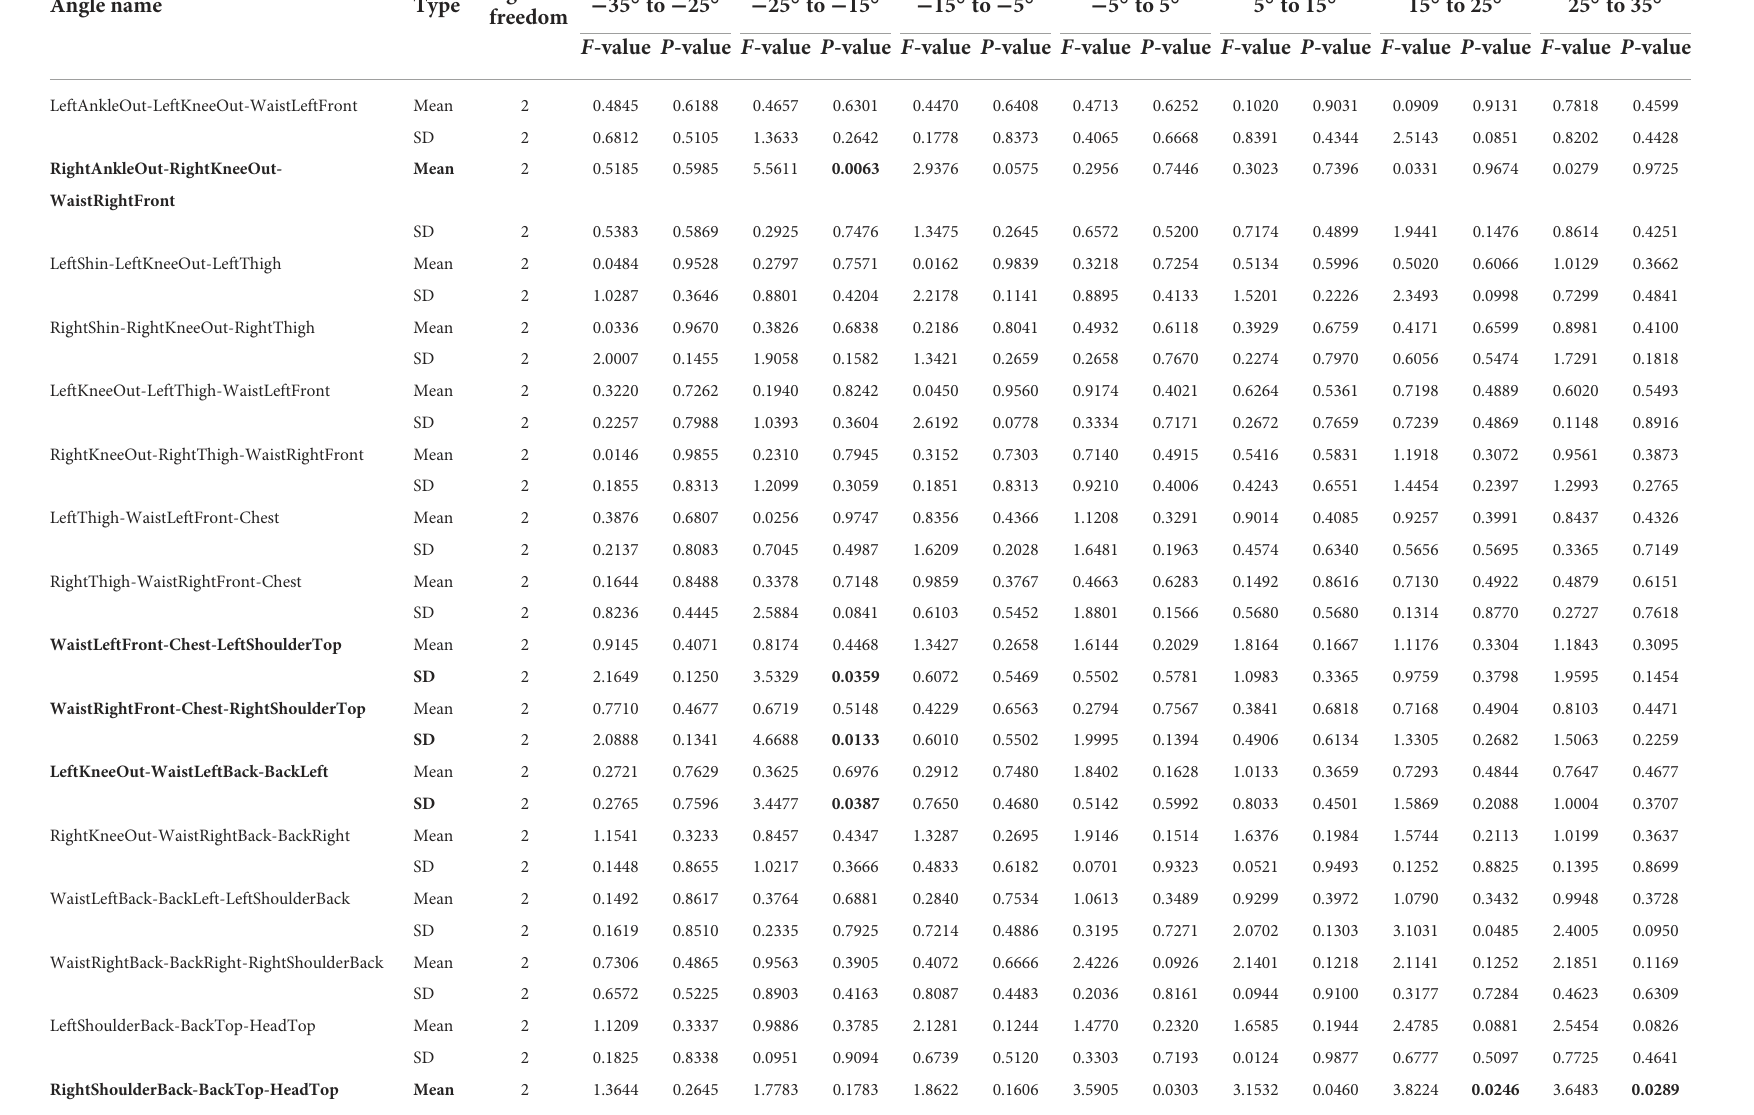
TABLE 5 Results of 1-way ANOVA for mean and SD of each angle in each straightness group (factor: reported